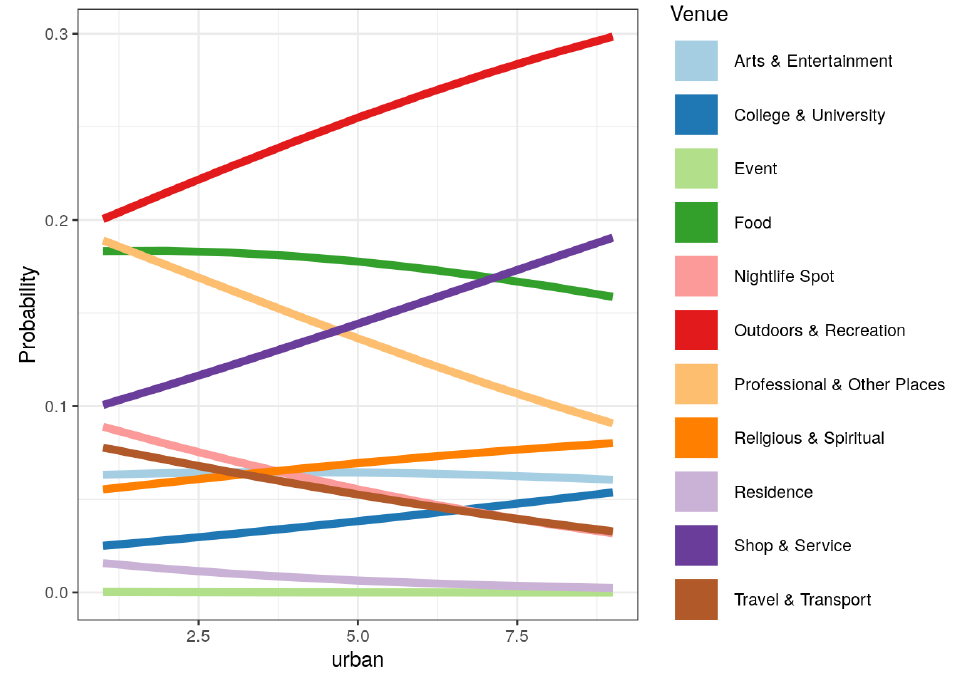
Figure 3. Multinomial Predicted Probabilities as a Function of Urban